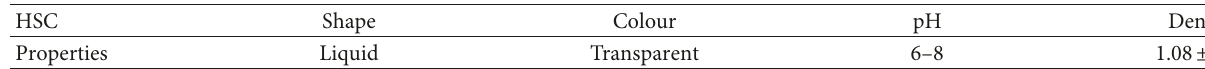
Table 2: Superplasticizer properties (HSC).